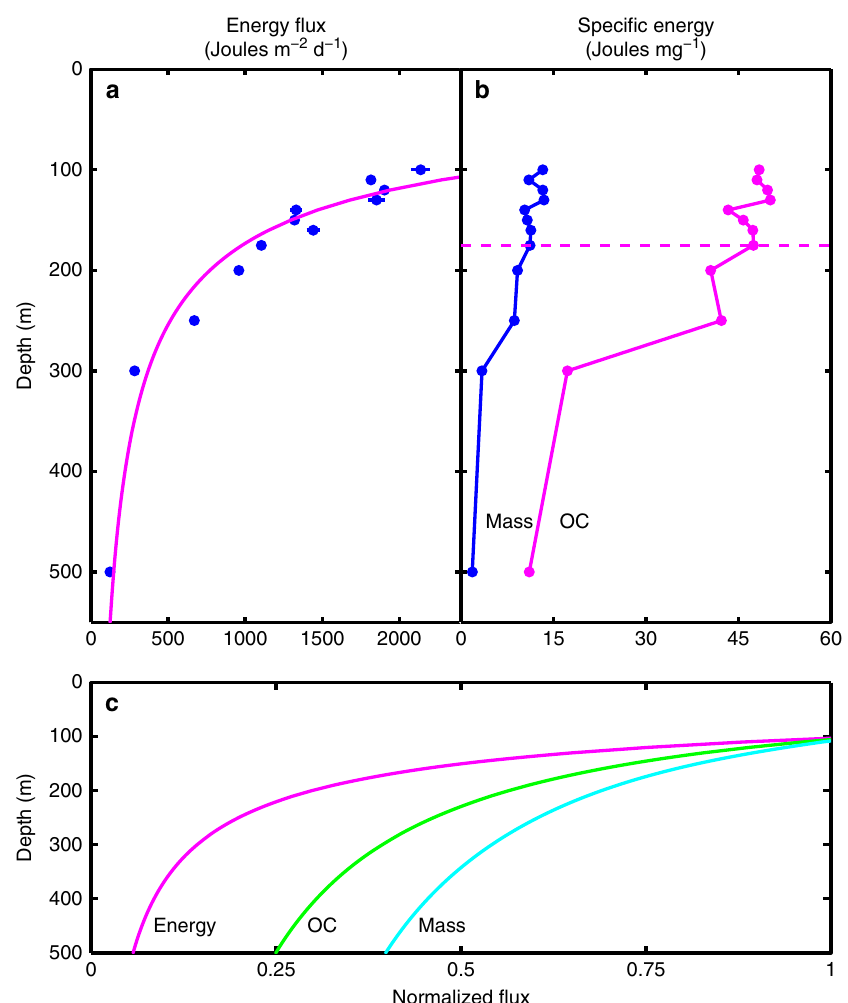
Fig. 2 Energy fl uxes. a Energy fl ux and b speci fi c energy of SPM expressed in mass-speci fi c (blue symbols) and OC-speci fi c (magenta symbols) units. The magenta curve on the left is the best fi t for the equation presented in Fig. 1 (also see Supplementary Fig. 2). The best fi t parameters are: F 100 = 2701.6 J m − 2 d − 1 , b = − 1.81, r 2 = 0.90. The horizontal magenta dashed line on the right is the approximate depth of the photosynthetic compensation irradiance (see text for details). c Schematic representation of the fl ux pro fi les and fl ux attenuation coef fi cients for mass (blue curve, b = − 0.60), OC (green curve, b = − 0.89), and energy (magenta curve, b = − 1.81)